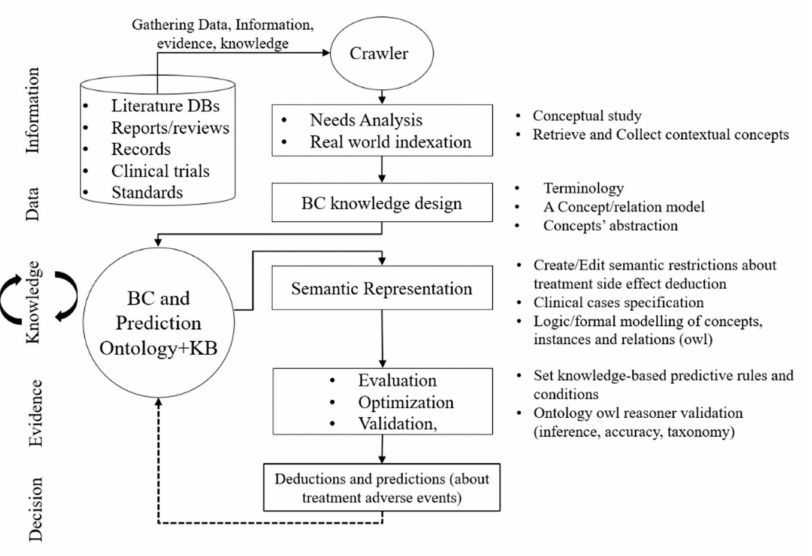
Figure 3. Ontology map and design